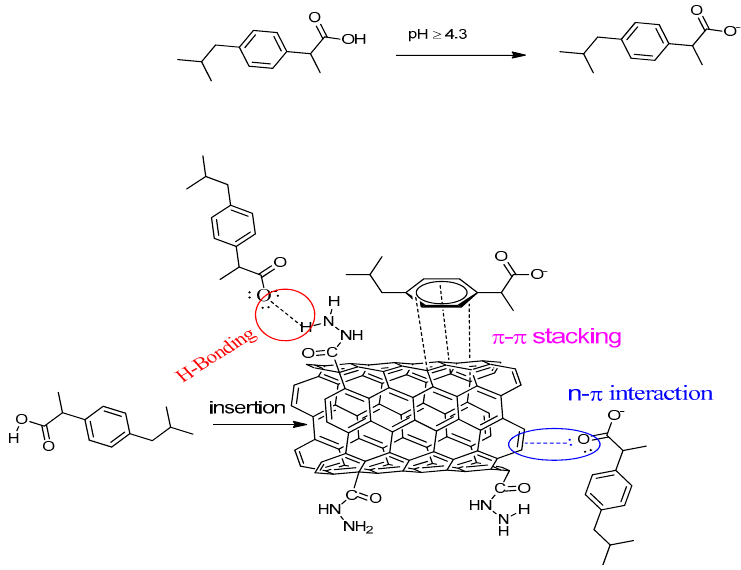
Figure 9. Mechanism of Ibu adsorption on m-MWCNT–HYD.